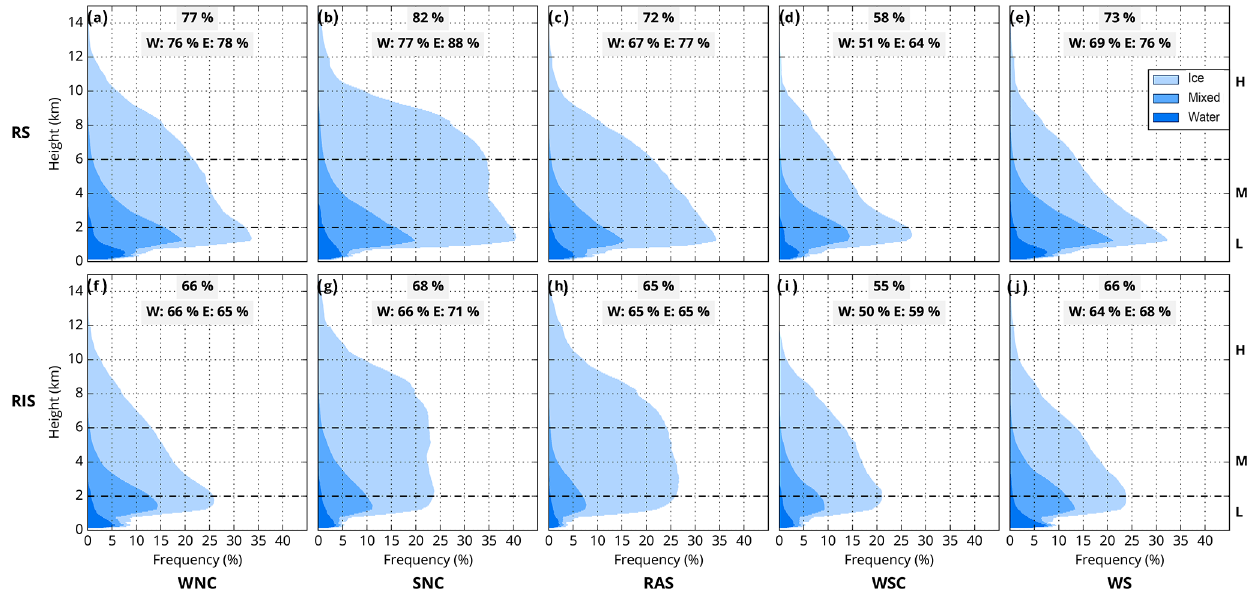
Figure 5. Mean vertical profiles of cumulative cloud occurrence for different cloud phases derived from 2BCL4 data for the Ross Sea (a–e) and RIS regions (f–j) for the Coggins regimes. L, M, and H labels indicate the low, medium, and high cloud regions, respectively, as discussed in the